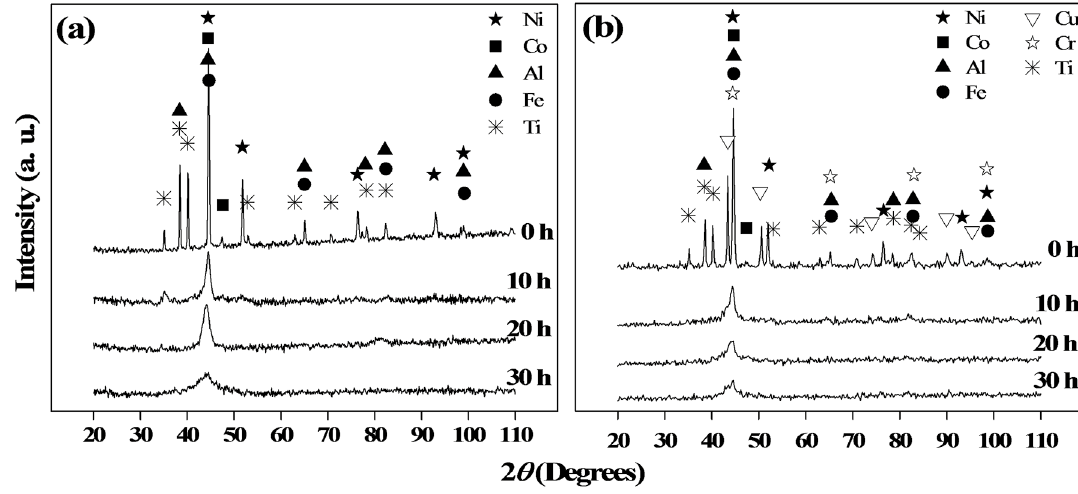
Figure 4. XRD patterns of the alloys: a) NiCoAlFeTi and b) NiCoAlFeCuCrTi, as a function of the milling time.